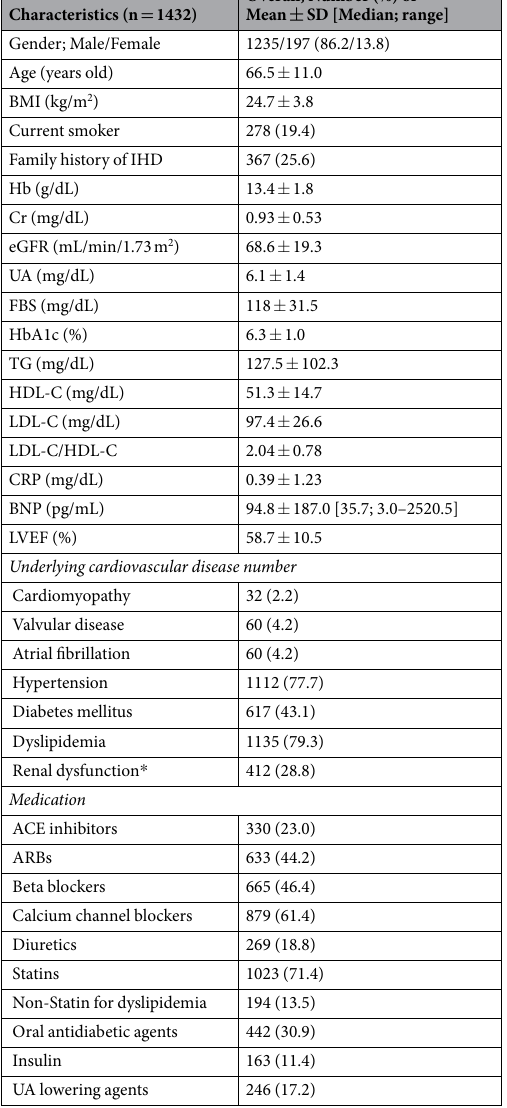
Table 1. Clinical characteristics. BMI, body mass index; IHD, ischemic heart disease; Hb, hemoglobin; Cr, Creatinine; eGFR, estimated glomerular filtration rate; UA, uric acid; FBS, fasting blood sugar; HbA1c, hemoglobin A1c; TG, triglycerides; HDL-C, high-density lipoprotein; LDL-C, low-density lipoprotein; CRP, C-reactive protein; BNP, B-type natriuretic peptide; LVEF, left ventricular ejection fraction; ACE, angiotensin- converting enzyme; and ARBs, angiotensin II type I-receptor blockers. * Renal dysfunction = eGFR < 60 mL/ min/1.73 m 2 (excluded hemodialysis-dependent